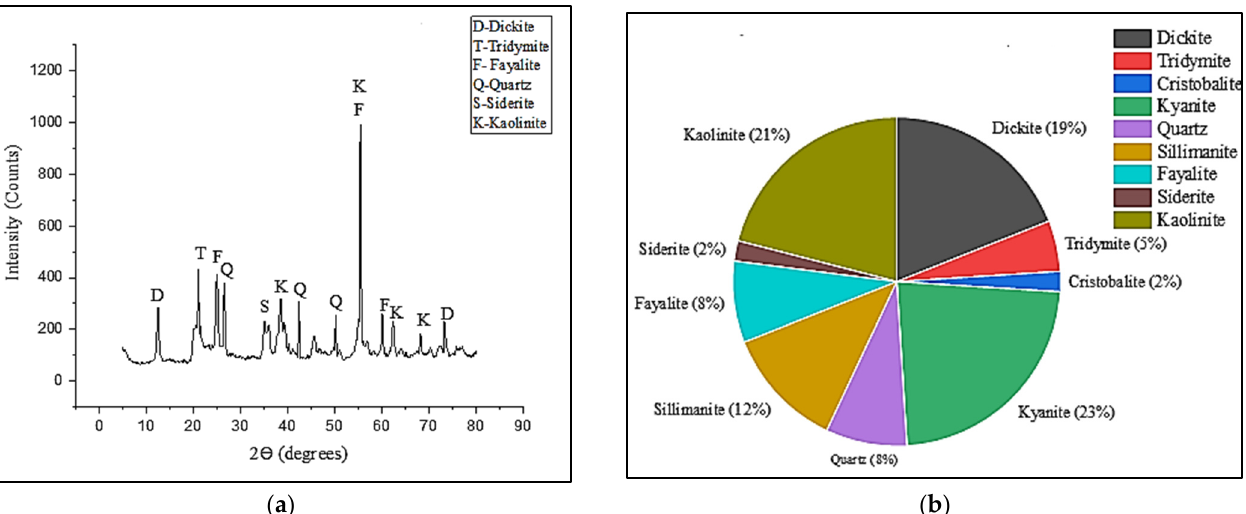
Figure 18. Characterization of minerals and compounds; ( a ) XRD analysis of Valandhur sample, ( b ) quantification of compounds.